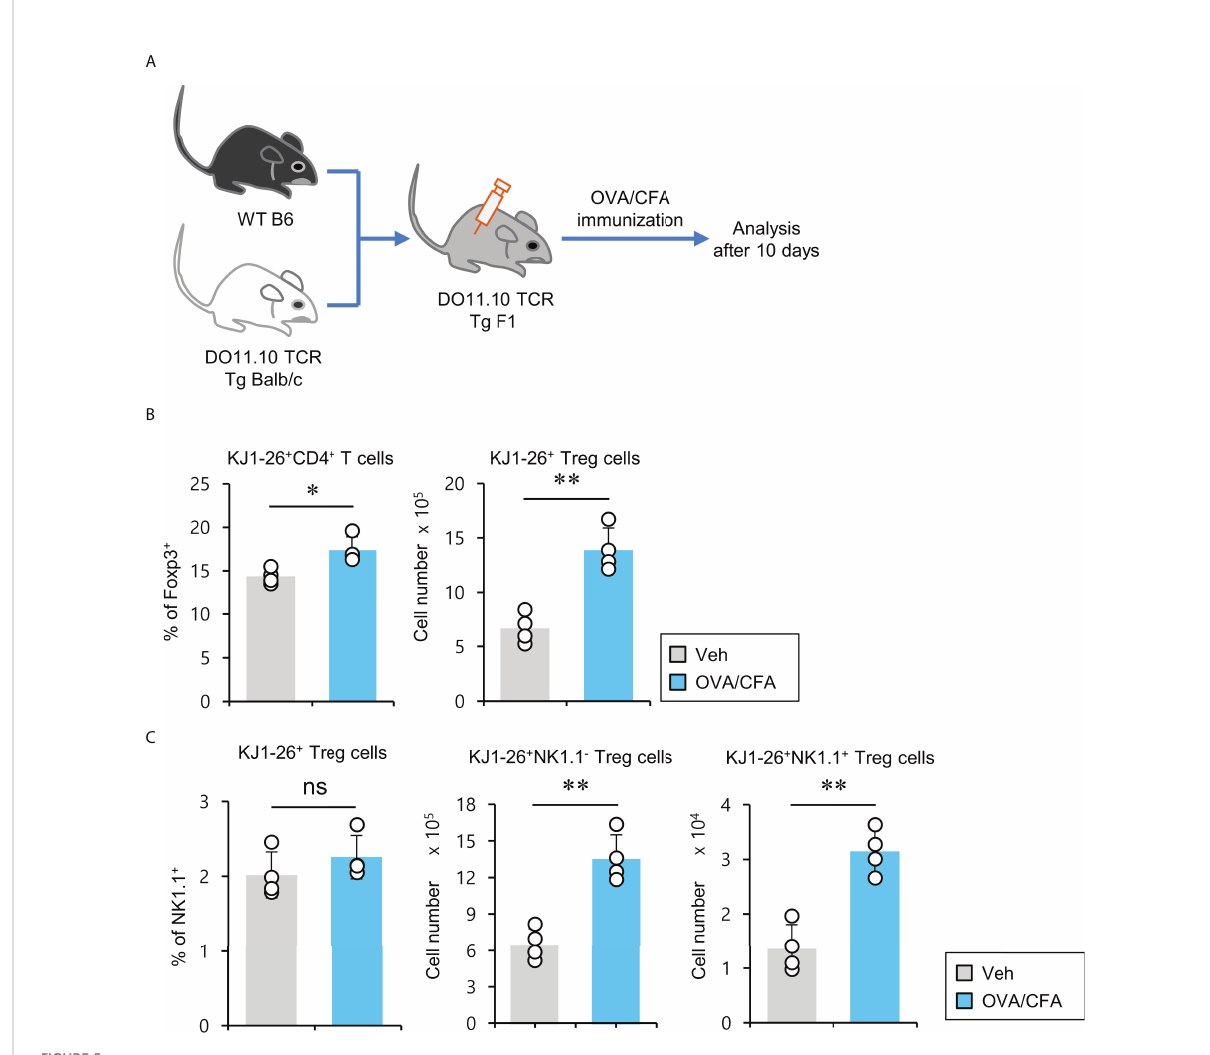
FIGURE 5 Expansion of antigen-speci fi c NK1.1 + Treg cells after immunization with CFA/OVA (A) DO11.10 OVA-speci fi c TCR transgenic (Tg) Balb/c × B6 F1 mice were immunized via subcutaneous injection with the OVA peptide emulsi fi ed in CFA. Ten days after immunization, splenic CD4 + T cells were enriched from these mice using MACS. (B) The percentage of Foxp3 + cells among splenic KJ1-26 + CD4 + T cells and the absolute cell number of KJ1-26 + Treg cells were assessed by fl ow cytometry. (C) The percentage of NK1.1 + subpopulation among splenic KJ1-26 + Treg cells and the absolute cell numbers of both KJ1-26 + NK1.1 - Treg and KJ1-26 + NK1.1 + Treg cells were assessed by fl ow cytometry. The mean values ± SD ( n = 4 per group in the experiment; Student ’ s t-test; * p < 0.05, ** p < 0.01). One representative experiment of two experiments is shown. ns, not signi fi